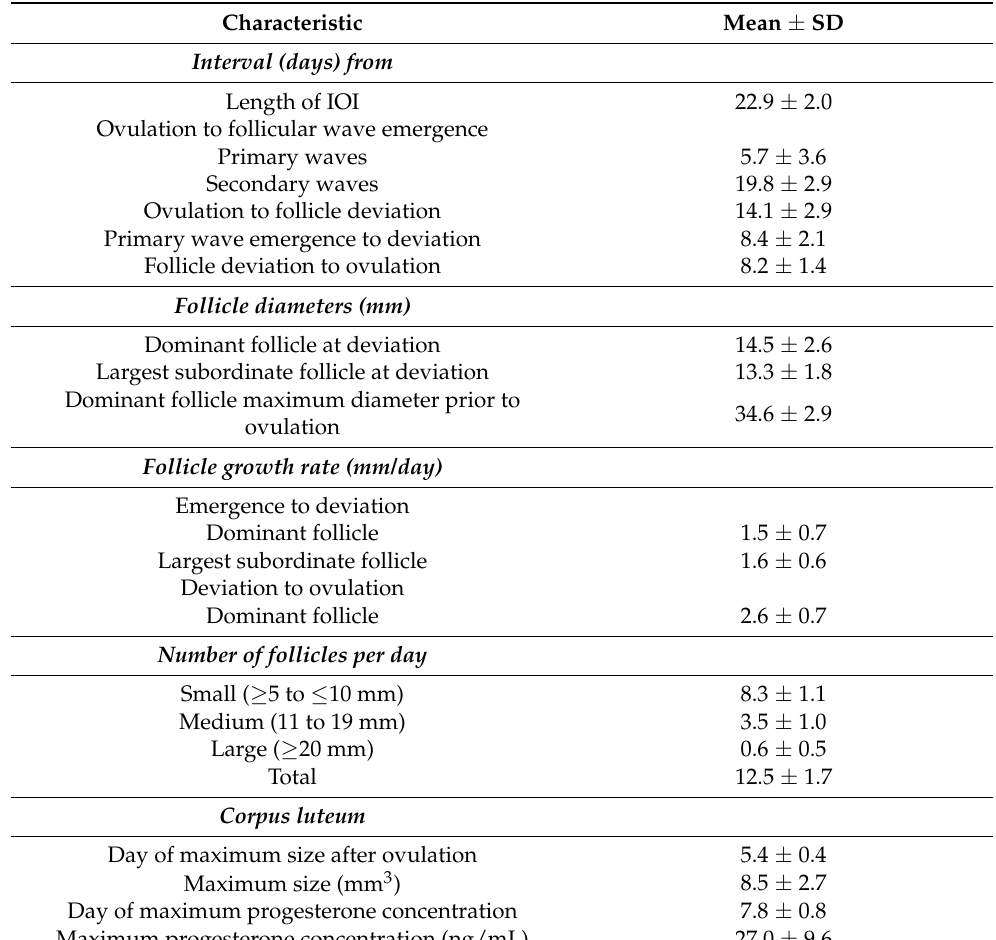
Table 1. Characteristics of follicular waves and structural and functional development of the corpus luteum of four estrous cycles in eight